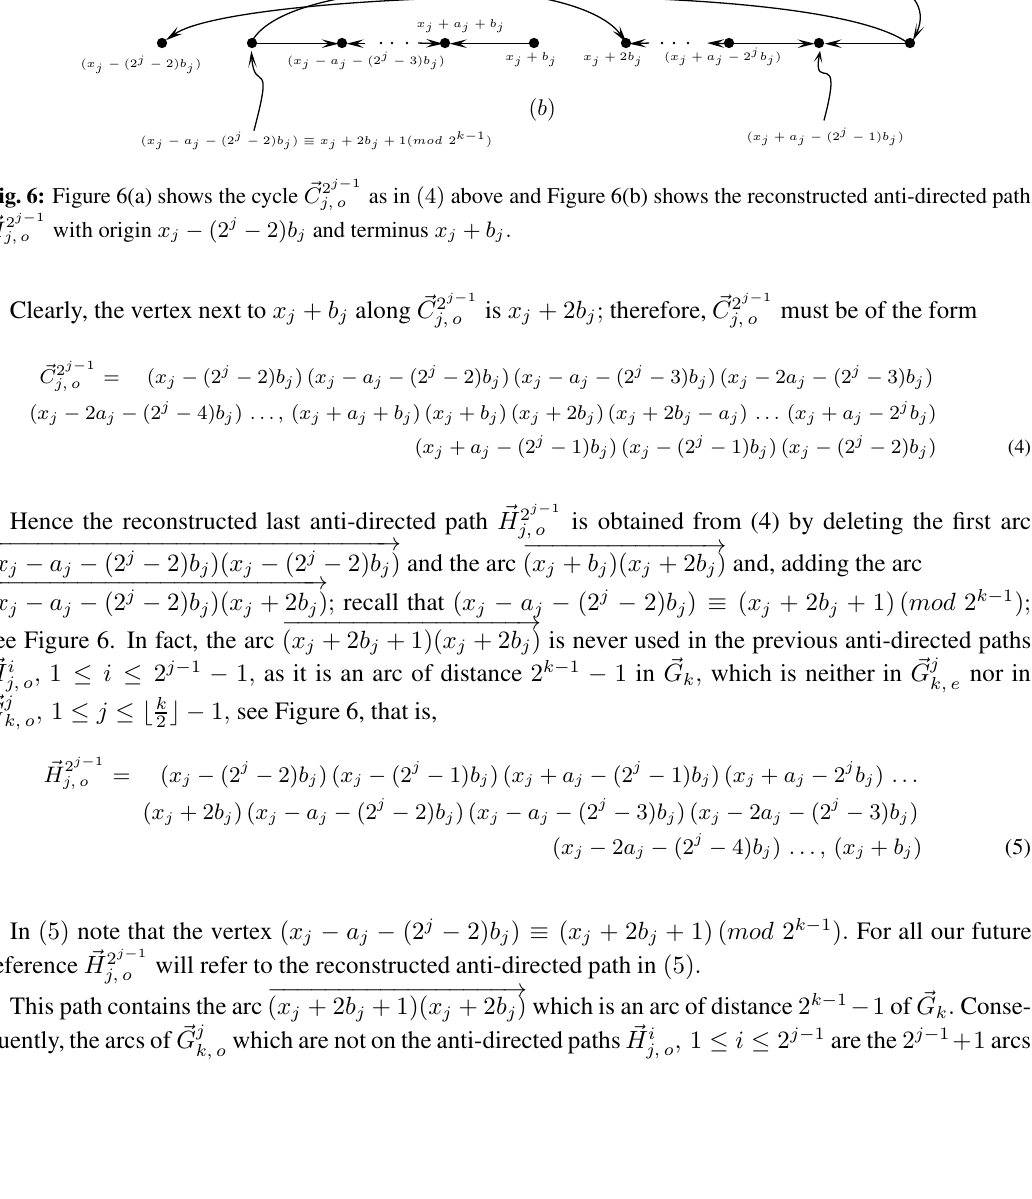
Clearly, the vertex next to x j + b j along ~C 2 j − 1